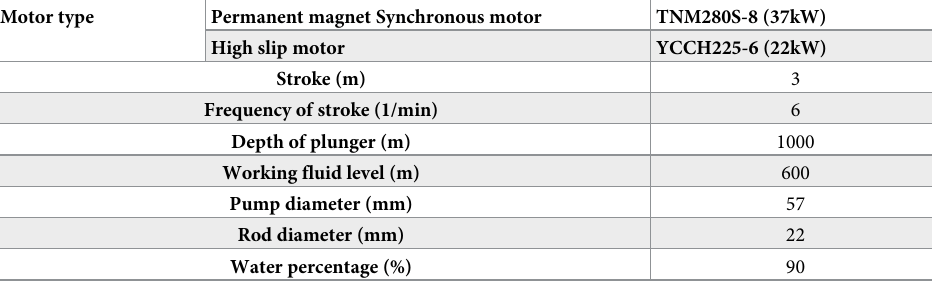
Table 2. Pumping well system pumping parameters.